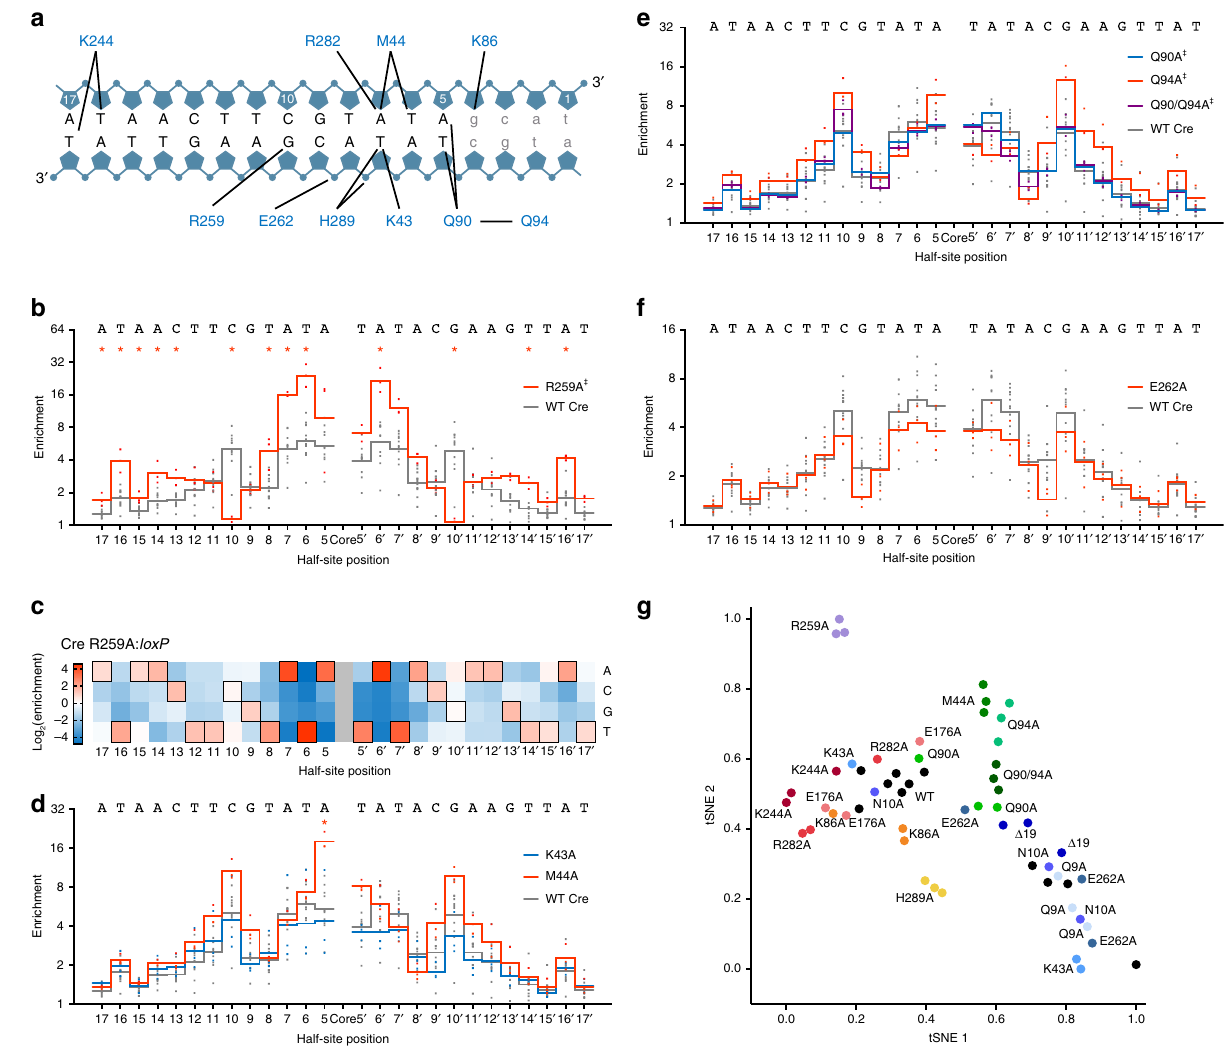
Fig. 2 Determinants of Cre: loxP speci fi city identi fi ed by Rec-seq on wild-type Cre and Ala-substituted Cre variants. a Protein:DNA contacts for Cre: loxP inferred from crystal structures 8 . b Rec-seq enrichment pro fi le for the CreR259A variant (red line) and wild-type Cre (gray line). c Heat map of Rec-seq enrichment values for the CreR259A variant showing the log 2 of the enrichment value for each nucleotide at each position in loxP relative to the canonical base (black outline). d – f Rec-seq enrichment pro fi les for Ala-substituted Cre mutants (colored lines) and wild-type Cre (gray lines). For b – f values represent the geometric mean of n = 3 or n = 11 (wild-type Cre) independent replicates (dots) conducted at 37 °C for 30 min at a 1:3 protein:DNA ratio. g The results of Rec-seq experiments on wild-type Cre (black dots) and variants thereof (colored dots) visualized using t-SNE multi-dimensional proximity analysis 37 , showing that experimental replicates are clustered by similarity across all speci fi city features. Signi fi cant differences ( p ≤ 0.05) relative to wild- type Cre at individual nucleotides (Student's t-test; colored asterisks) and across the full log-enrichment pro fi le (Mann-Whitney U test; ‡ ) are indicated. Source data are provided as a Source Data fi